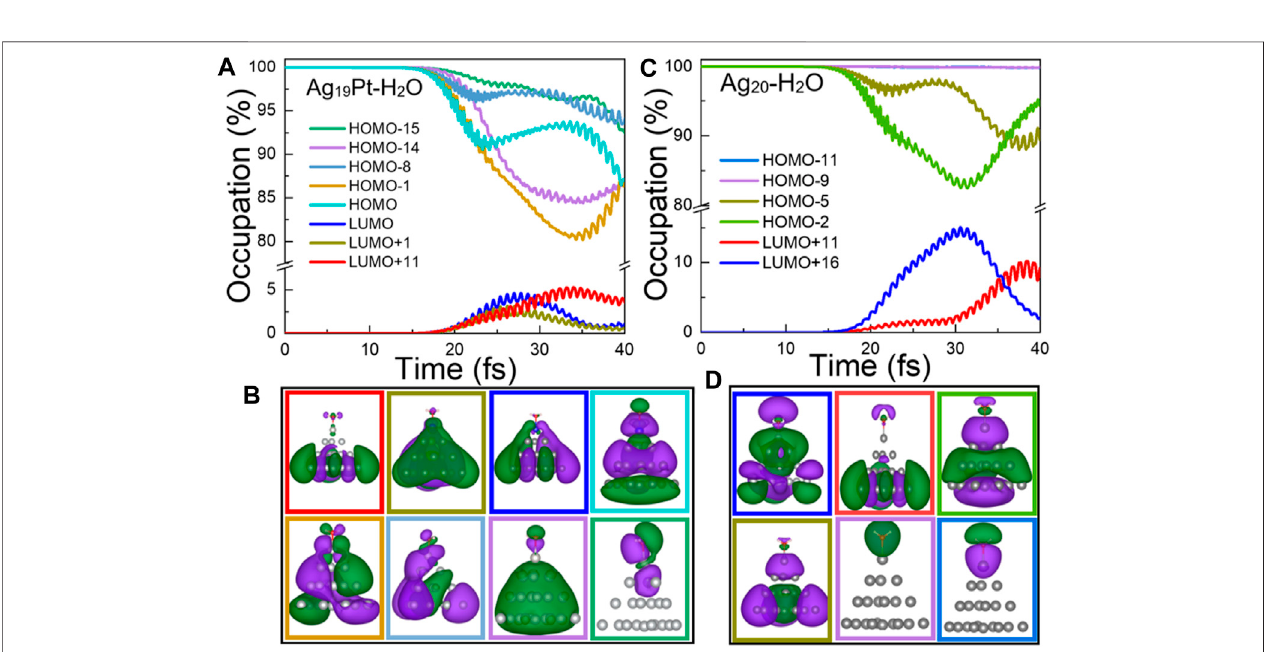
FIGURE4| Time-evolvedoccupationofKohn – Shamstatesandwavefunctionplots. (A) Time-evolvedoccupationand (B) thecorrespondingwavefunctionsofthe eightstatesshown indifferentcolorsforAg 19 Pt – H 2 Oundera fi eldstrength of0.1 V/Å. (C) Time-evolvedoccupationand (D) thecorrespondingwavefunctionsofthesix states shown in different colors for Ag 20 – H 2 O under the same condition. Here, the isosurface value for the wave functions is 0.02 Å − 3 .